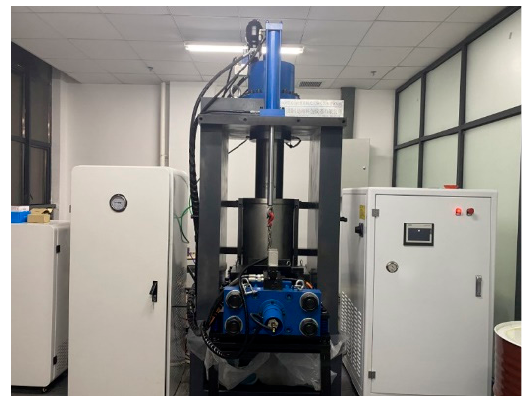
Figure 2. DSZ-1000 mechanical experimental system.